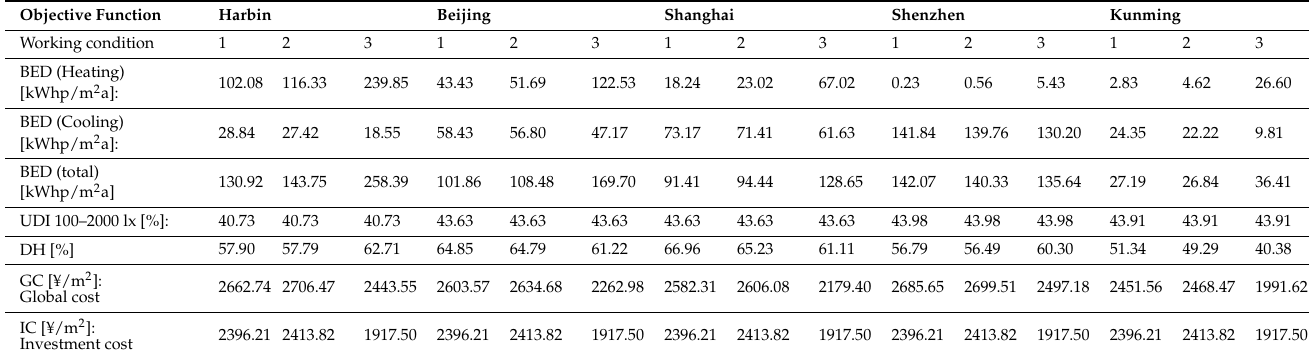
Table 16. Average performance indicators of building type 3 under the climatic conditions of each typical city. Objective